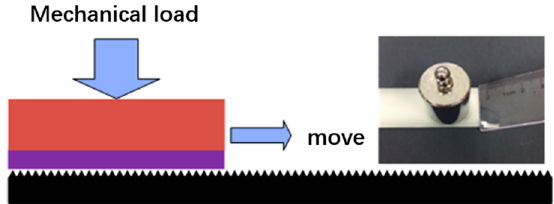
Figure 5. Schematic diagram of the wearing test of the super-hydrophobic surface.